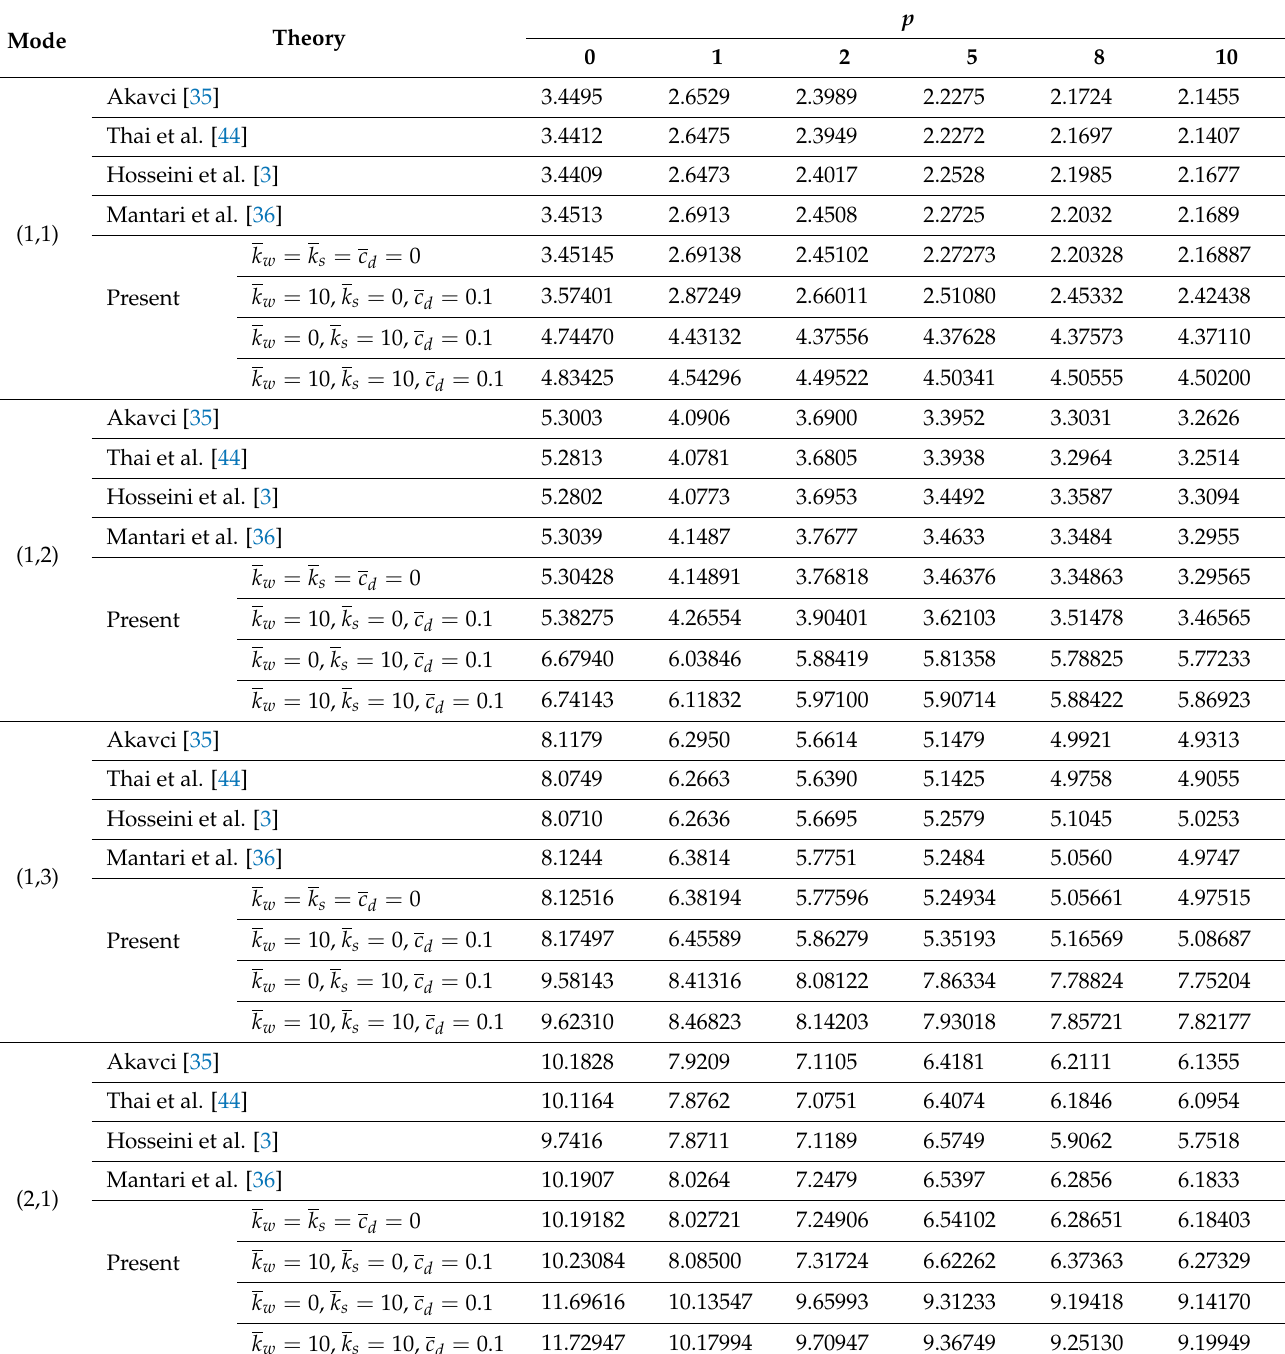
(cid:1)(cid:112) (cid:0) ω a 2 / h ρ c / E c for Al/Al 2 O 3 FG